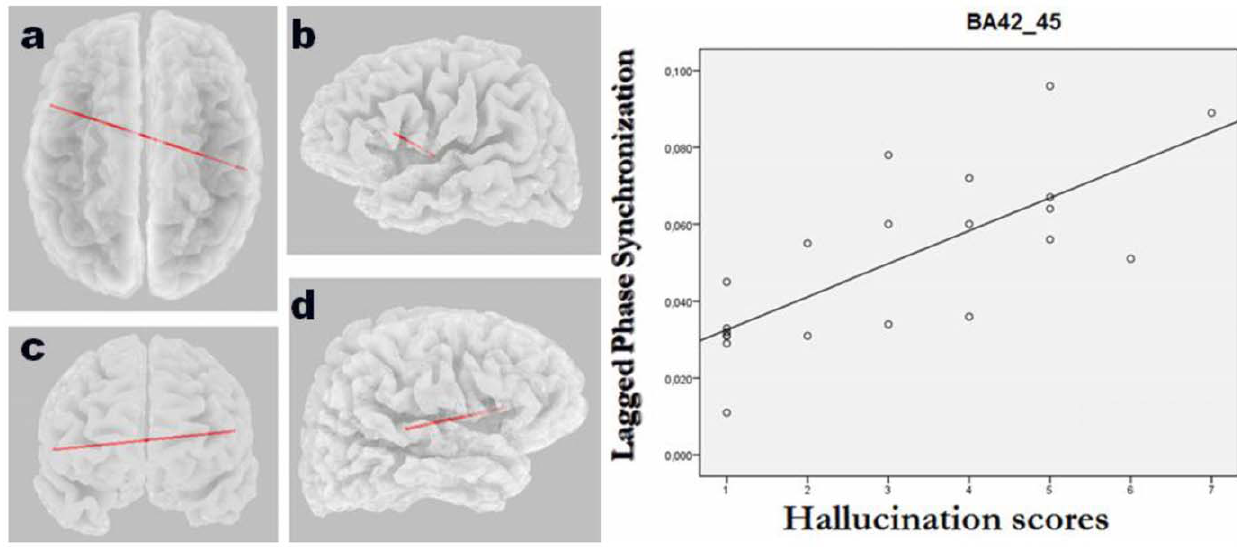
Figure 5. eLORETA wire diagram and scatterplots showing a significant correlation between interhemispheric beta2 (21-30 Hz) phase synchronization of right auditory cortex and the Broca’s area with auditory hallucination scores among patients with schizophrenia-like psychosis of epilepsy (r=0.82; p , 0.05, corrected). The significant connectivity wire is projected onto a transparent fiducial cortical surface. a) axial view from the top; b) sagittal view from the left; c) coronal view from the front d) sagittal view from the right. The points to which the lines are connected represent the center of mass of the BAs. BA 42_45, connectivity between Brodmann areas 42 and 45.